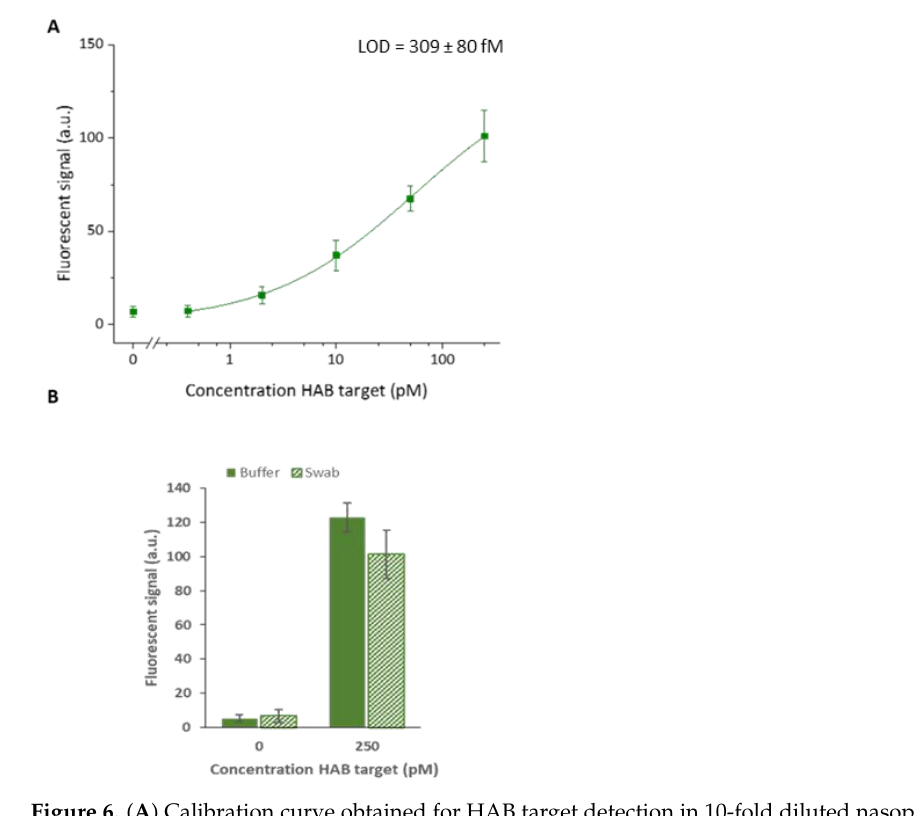
Figure 6. ( A ) Calibration curve obtained for HAB target detection in 10-fold diluted nasopharyngeal swab samples spiked with 250, 50, 10, 2, 0.4 pM and a blank. The calculated LOD is also indicated in the figure. ( B ) Comparison of the signal to buffer sample. Hybridization chain reaction was performed for 60 min. The error bars represent one standard deviation ( n = 3).